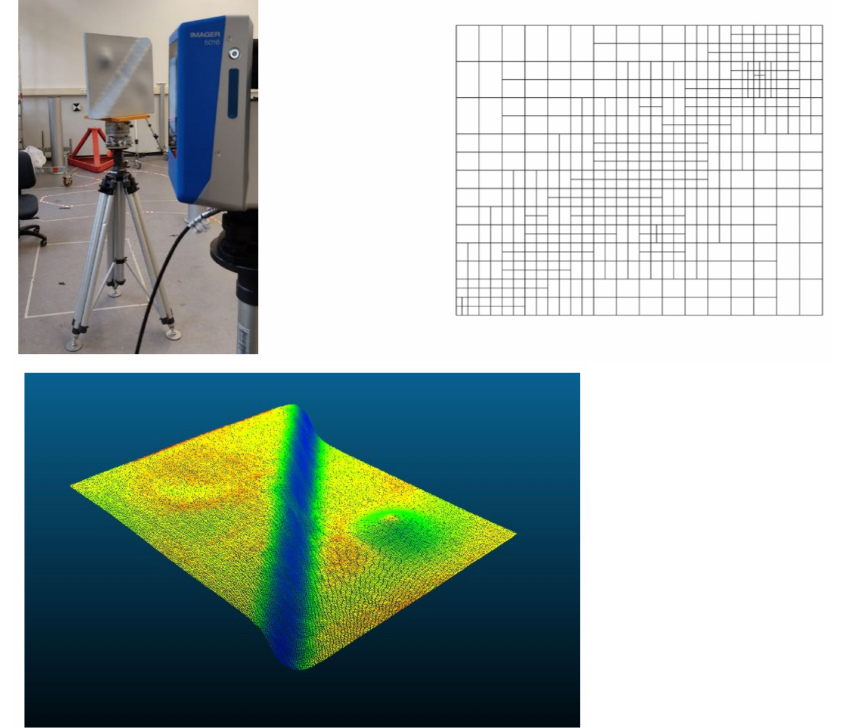
Figure 8. Top : left : the printed surface scanned at the laboratory of the Geodetic Institute in Hanover; right : the corresponding T-mesh. Bottom : the 3D point cloud visualized using the free software